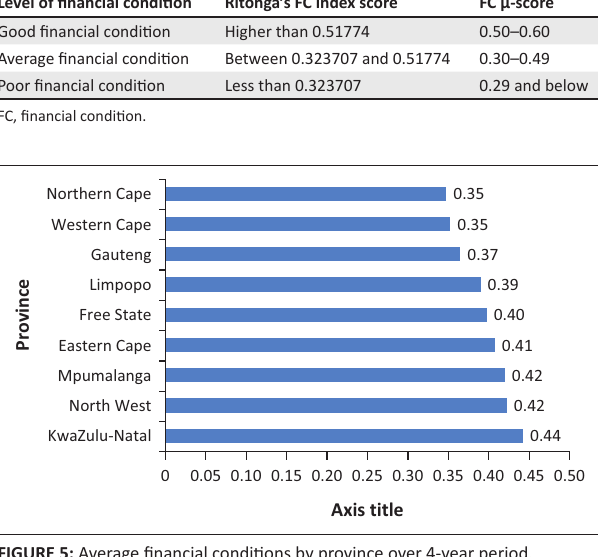
FIGURE 5: Average financial conditions by province over 4-year period.